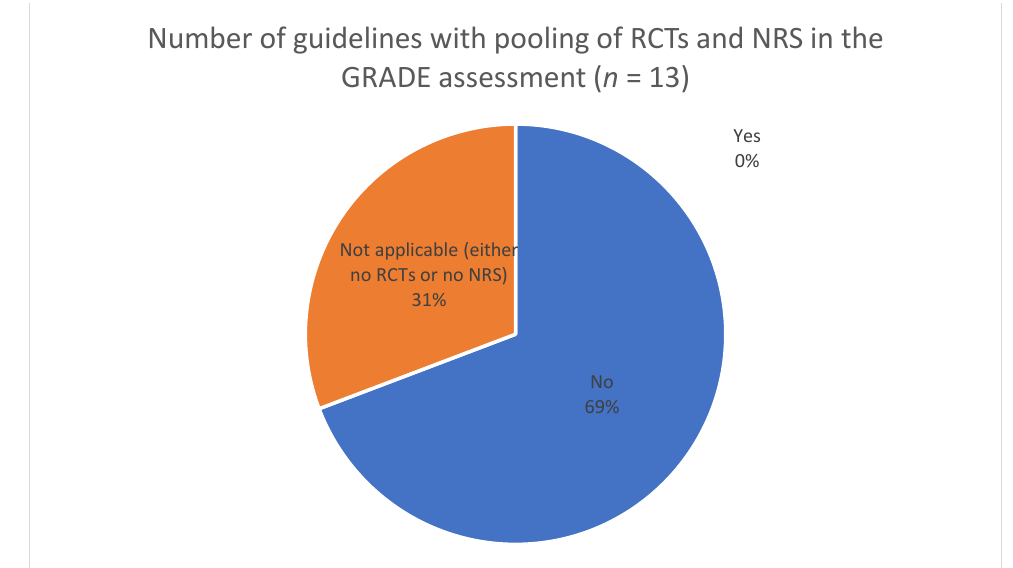
Figure 6. Pooling of RCTs and NRS when assessing the certainty of evidence. For theme 5 (addressing implications for decision-makers, including concerns about conditional recommendation), we first identified whether the guideline included strong recommendations based on low or very low CoE (Figure 7). The units of analysis were the extracted texts on the rationale for such recommendations. We identified the codes and developed categories describing the panels’ different reasons for developing strong rec- ommendations based on low or very low CoE. We then added further explanations and examples of such recommendations, one for each category (Table 4). Four reasons have been previously identified by Hilton Boon et al. [5]: life-threatening situations; uncertain benefit but certain harm; potential equivalence of effectiveness in which one option is clearly more or less risky or costly; and potential for catastrophic harm. We will include these as predefined categories in the full review. Here, we only present the newly identi- fied categories (Table 4).